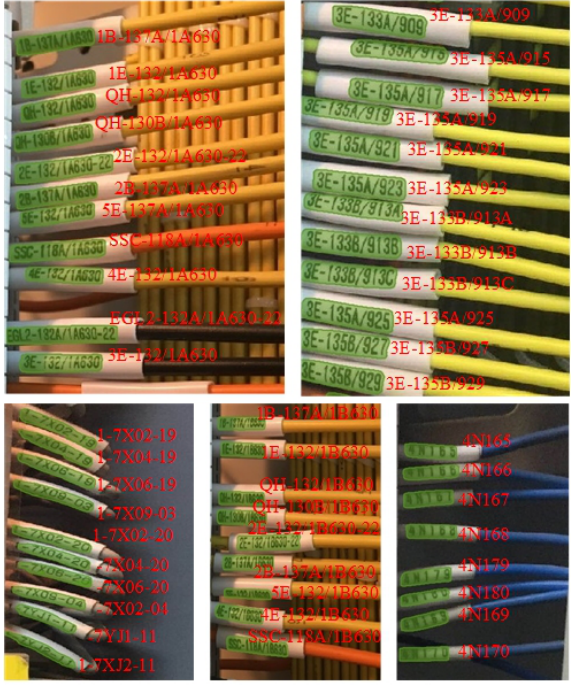
Figure 8. Some spotting results of Rwin-FPN++.